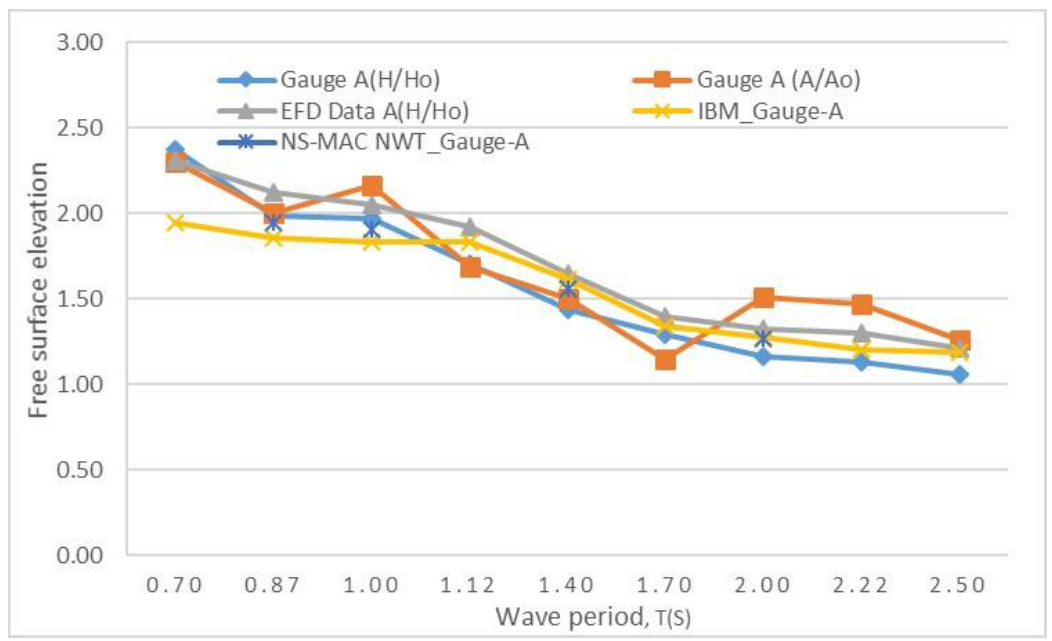
Figure 5. Comparison between computational fluid dynamics (CFD), experimental and numerical data of wave amplitude and heights for location A [5,25,26].